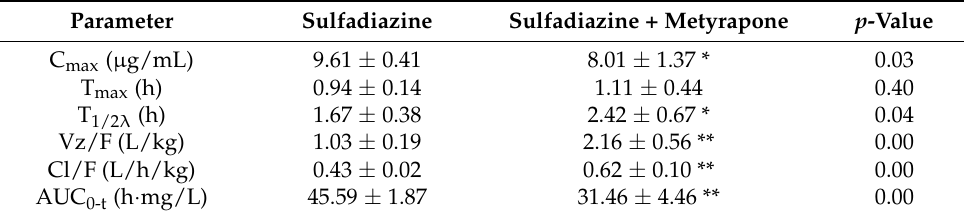
Table 1. Pharmacokinetic parameters of orally administered sulfadiazine in